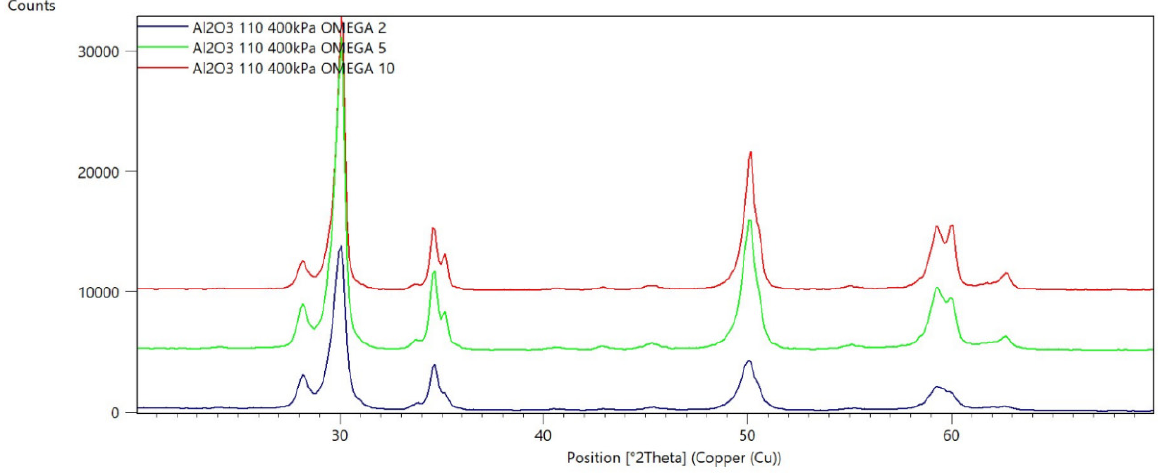
Figure 5. Diffraction patterns of sample D (abrasive—Al 2 O 3 110 μ m, pressure 400 kPa).